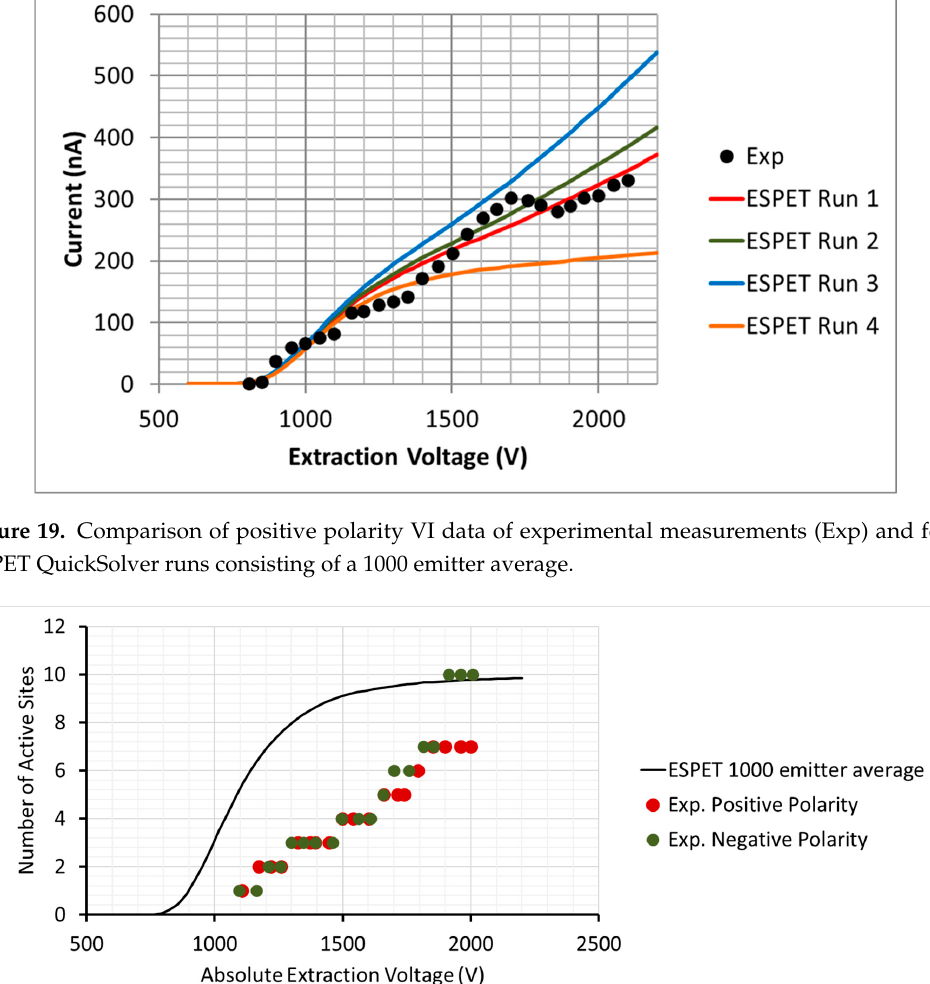
Figure 21. Conical porous borosilicate glass emitter used to benchmark ESPET.